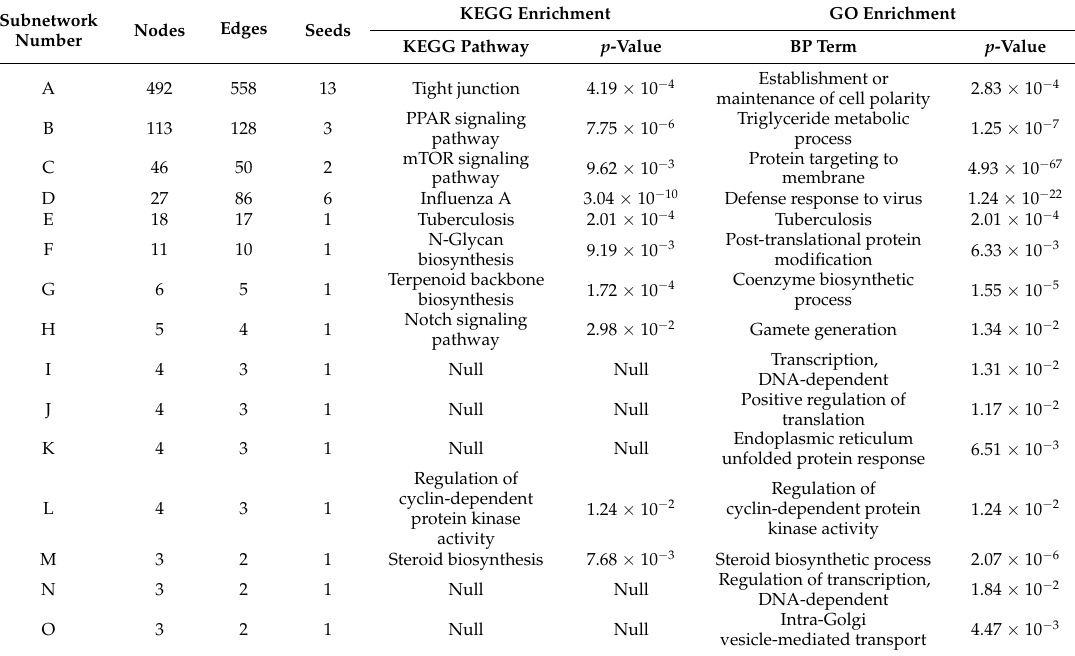
Figure 6. The breast tissue specific co-expression network with DEGs generated by the TCSBN (Tissue and cancer specific biological networks) database (http://inetmodels.com/) through the NetworkAnalyst (https://www.networkanalyst.ca/) web server. ( A – O ), the subnetworks of co-expression network origin from the seeds of DEGs. Table 2. The tissue specific co-expression network regulated by bufadienolide-like chemicals and their enrichment with GO and